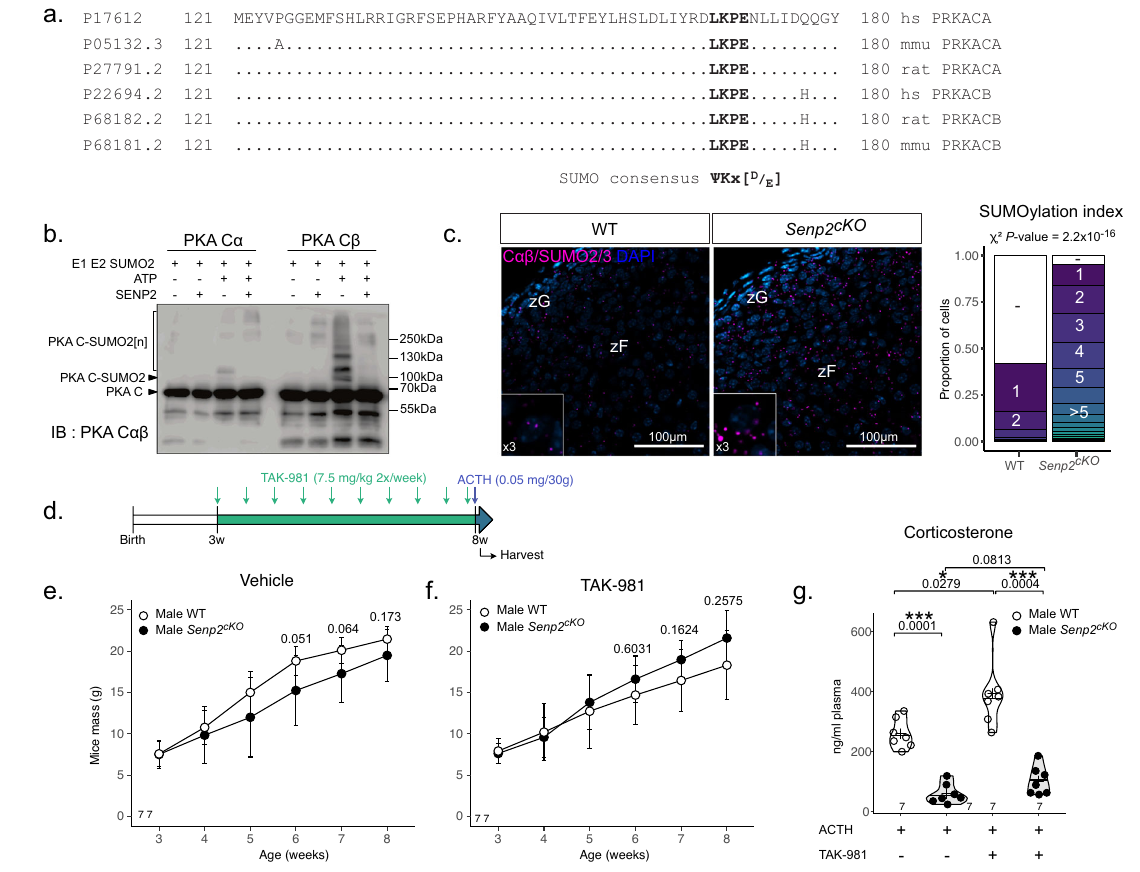
Fig.4|SENP2deSUMOylatesPKAcatalyticunits.a Sequencealignmentof Homo sapiens , Mus musculus and Rattus norvegicus PRKACA (C α ) and PRKACB (C β ). b In vitro SUMOylation assay of PKA C α and C β in presence or absence of SENP2. c Proximity ligation assay analysis of PKA C α / β in WT and Senp2 cKO 4-week-old adrenals. d Schematic representation of the experimental setup of mice treat- ments. e Weight monitoring of WT and Senp2 cKO mice treated with vehicle